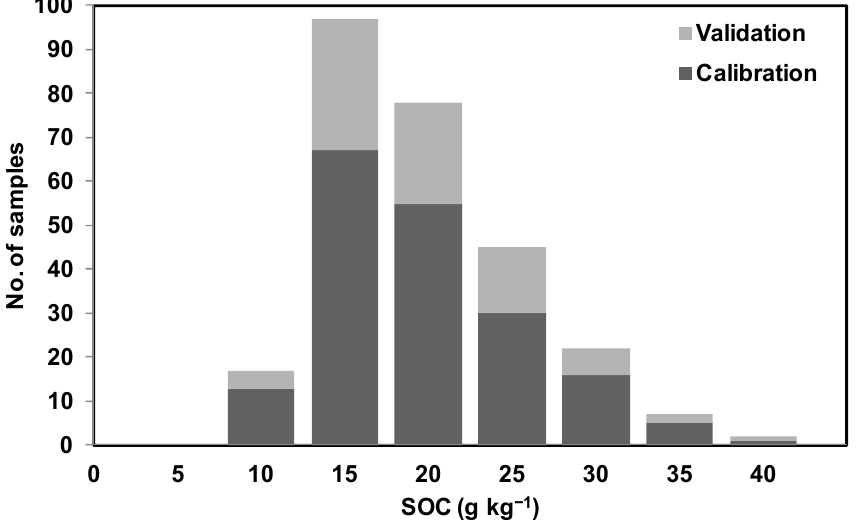
Figure 7. Illustration of distribution of clay content using stacked histogram with two categorical variables (calibration data and validation data).